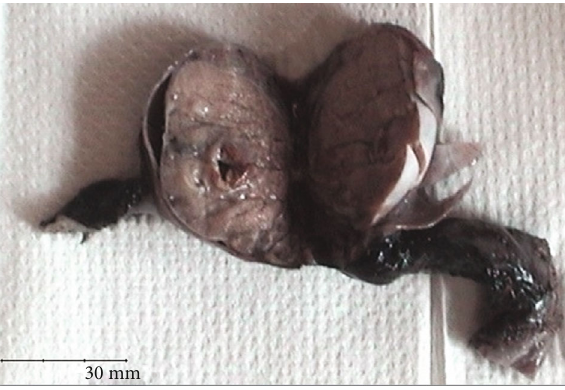
Figure 2: Macroscopically, the intratesticular tumor appeared cystic with an endoluminal solid